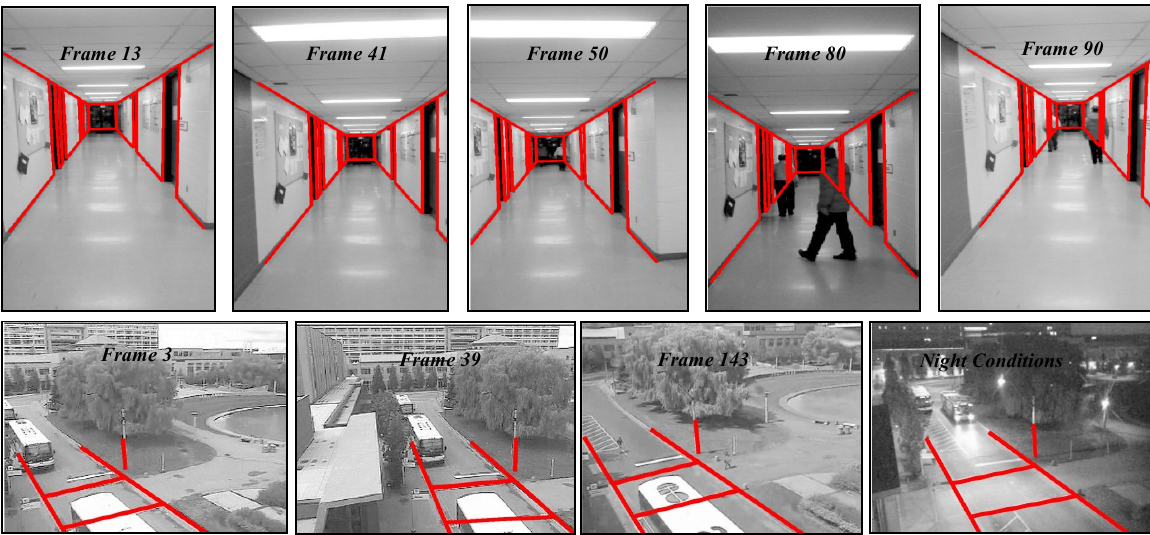
Figure 10. Image sequences registered with Wireframe models (red lines). Indoor dataset (Top row). Outdoor dataset (Bottom